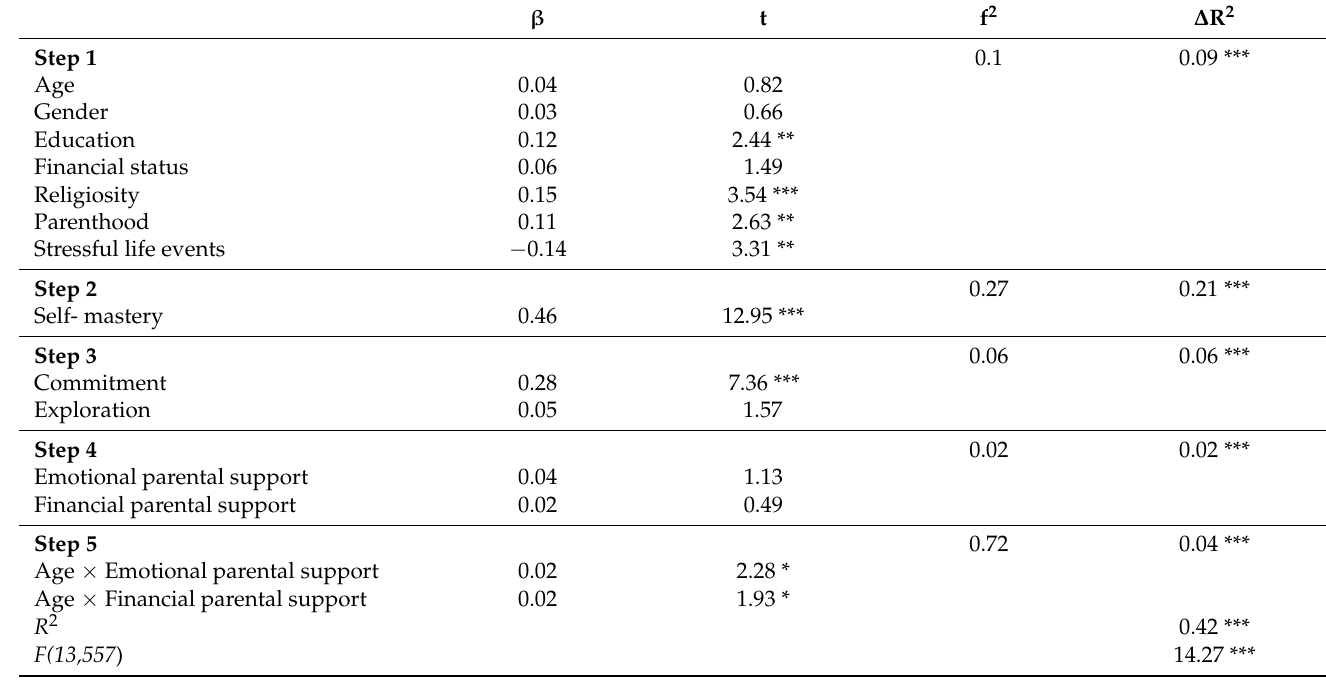
Table 3. Hierarchical Regression Coefficients (Beta Weights) for Satisfaction with